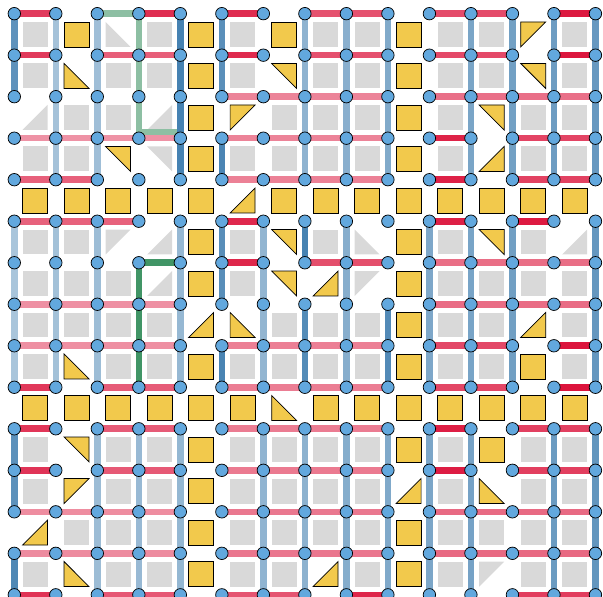
FIG. 5. The modularization of a larger layout with additional explicitly enforced constraints (yellow) arranged in a grid for constant-circuit-depth implementation of driver terms. All blue lines and all red lines can be implemented in parallel, respec- tively. The green lines, which are caused by implicitly enforced three-body constraints, only add a small contribution to the depth and are partially parallelizable with the other steps. In each sub- module, one driver line is omitted as it can be obtained via symmetric difference of the